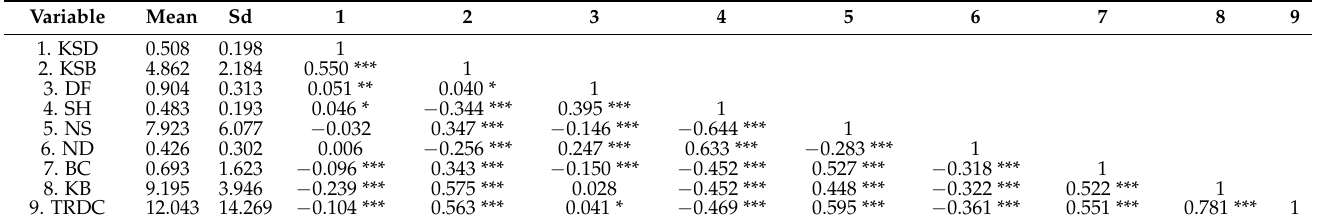
Table 1. Descriptive statistics and person correlation matrix.